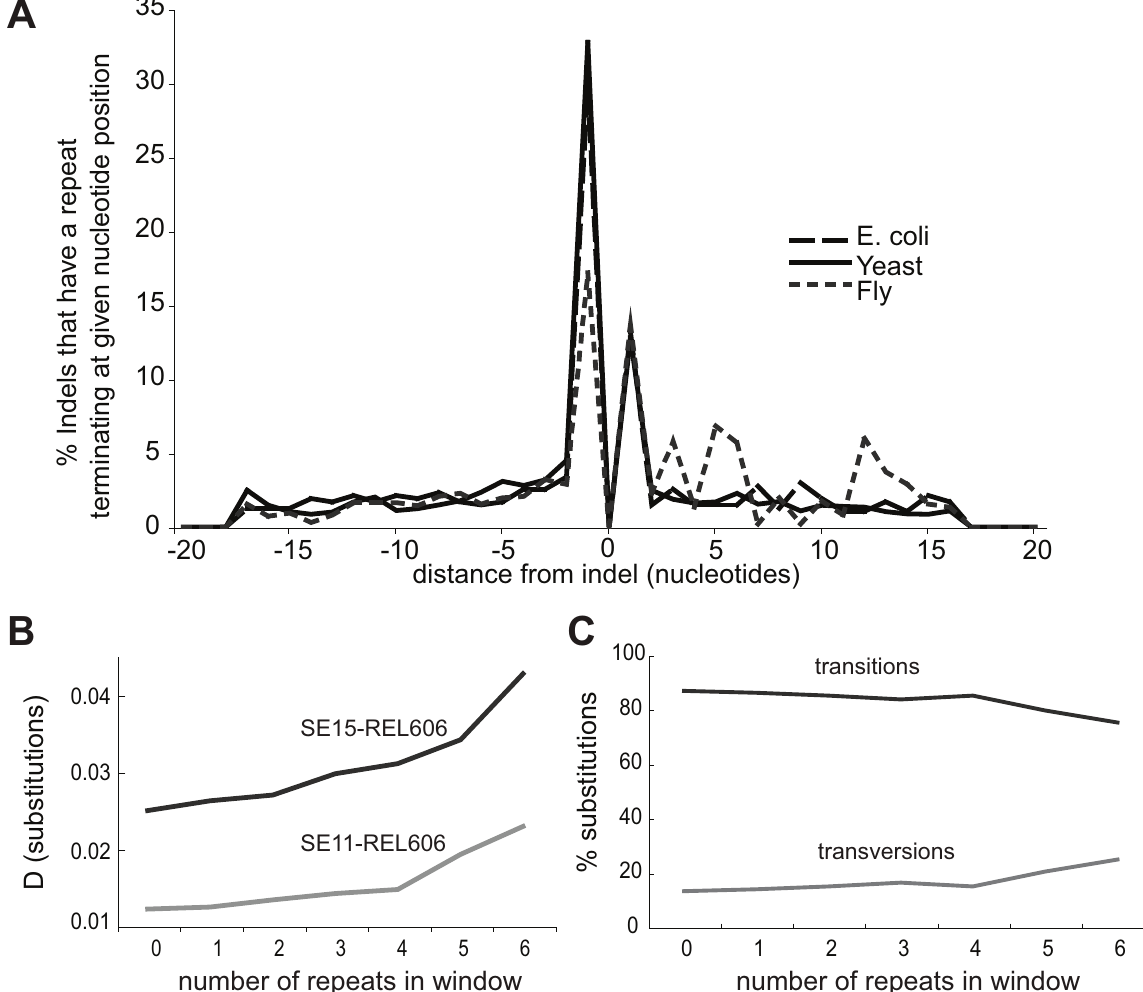
Figure 6. Repeat-rich sequence windows contain increased sequence diversity. The location of repeat sequences often coincides with indel position in E. coli , S. paradoxus , and Drosophila . Shown are the 20 nucleotides upstream (negative integers) and downstream (positive integers) of the indel (position zero). A repeat is scored once in the nucleotide position in which it terminates, for example, A repeat of four A’s running from position 2 5 to 2 1 is recorded as a repeat at position 2 1 (A). Sequence windows from new E. coli alignments not containing indels were binned according to the number of 4 mer homonucleotide repeats they contained. D was found to increase with the increased number of repeats (B), as did the ratio of transversion to transition substitutions (C). The repeat density effect was stronger in a more diverged two-strain comparison (B), indicating that repeats are associated with the accumulation of substitutions over time.